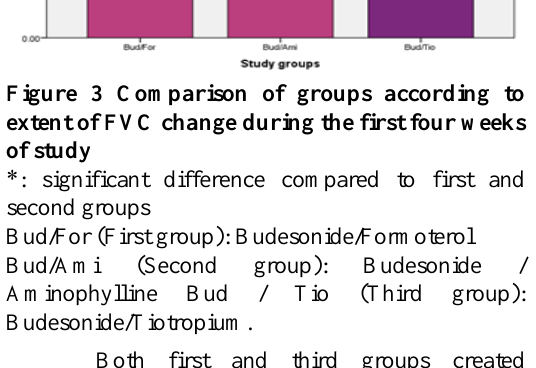
Figure 4.Comparison of groups according to extent of FVC change during the second four